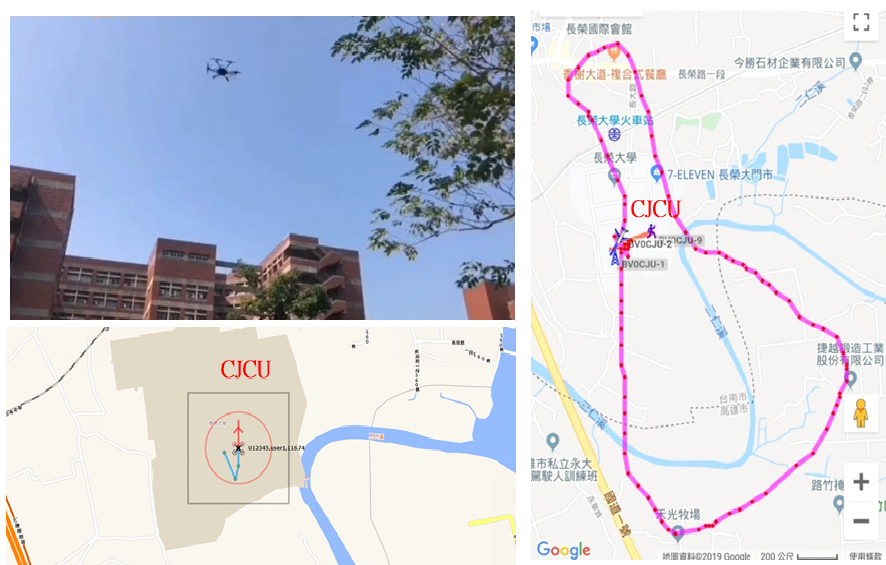
Figure11. Figure 11. APRS flight test on CJCU campus with real-time tracking on UTM display and its flight record.